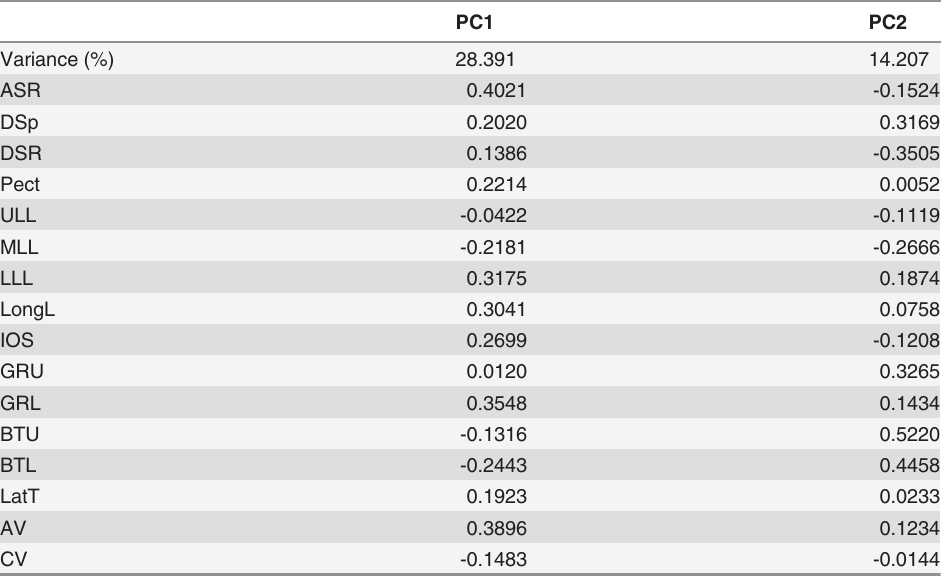
Table 1. PCA on meristics of the inter-specific analysis.